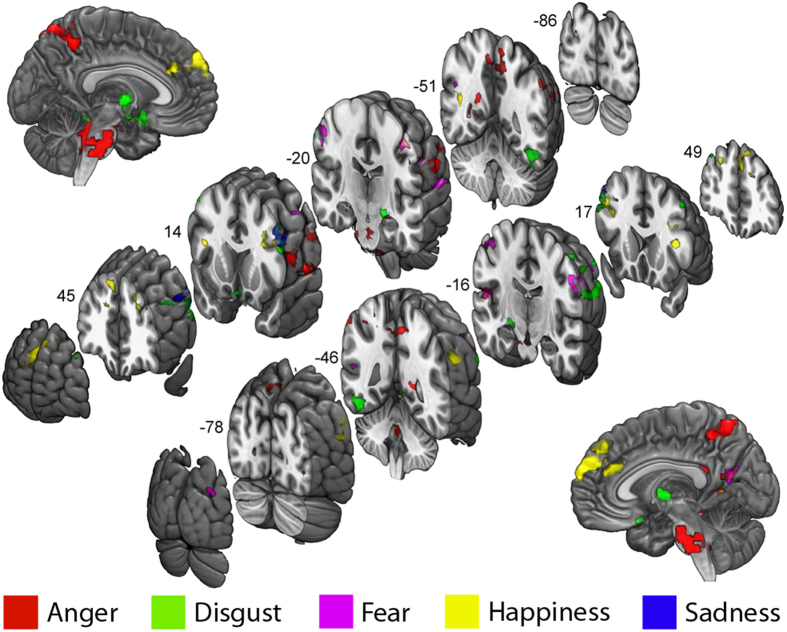
Brain areas showing significant emotion-dependent functional interactions with the amygdala for the contrast of each emotion with the neutral expression condition separately.MNI Y coordinates are reported for each slice. Results are whole-brain thresholded at Z > 2 and cluster corrected at p < 0.05.